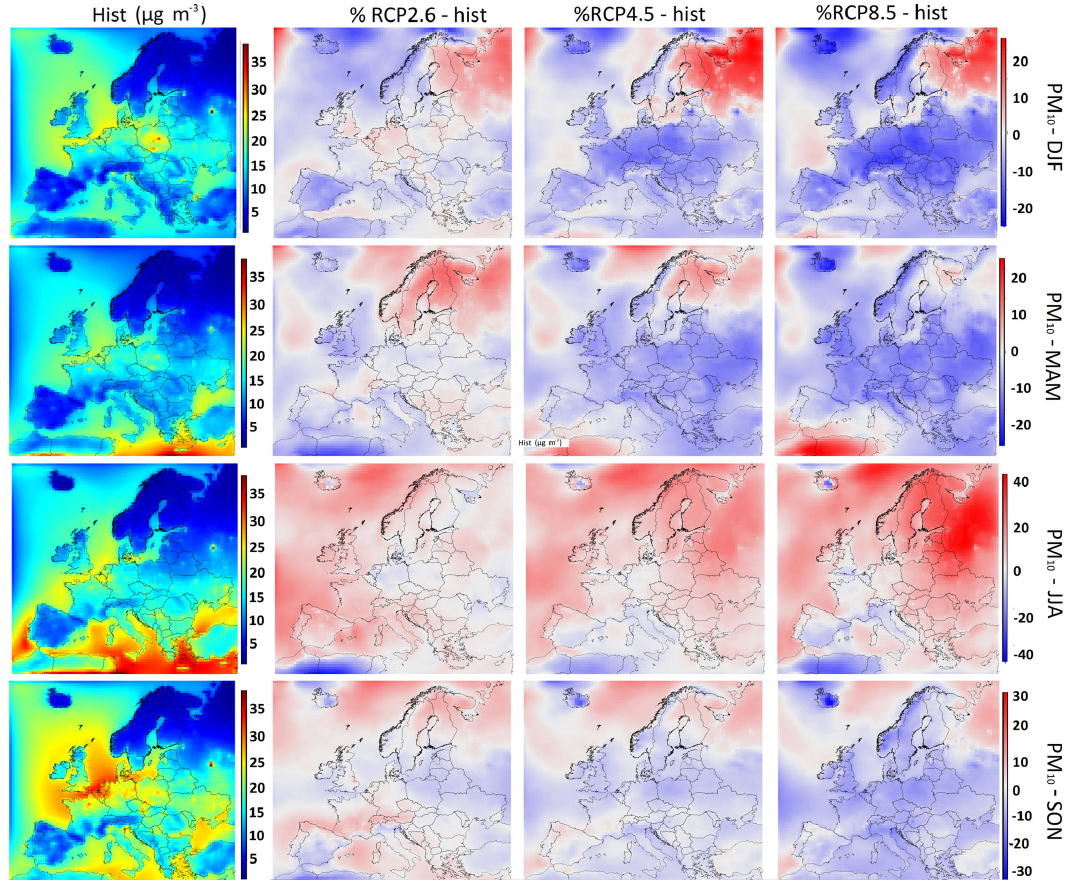
Figure 5. PM 10 seasonal average concentrations in the historical simulation (first column). Relative differences between the climate simula- tions (RCP2.6, RCP4.5 and RCP8.5) and the historical simulation (Hist) (second, third and fourth columns, respectively). Rows represents the different seasons (winter, spring, summer and fall, from top to the bottom). Please note that the scale used differs between seasons for the sake of